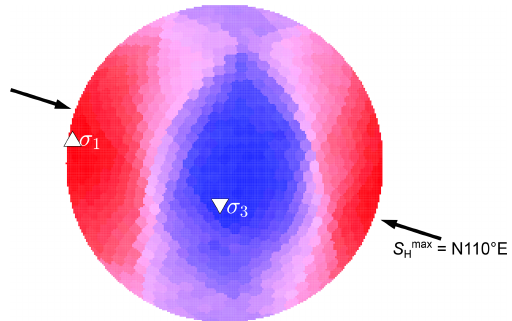
Figure 9. Stereonet of the estimated local stress field using the BRTM. White upward- and downward-pointing triangles represent maximum and minimum principal stress axes σ 1 and σ 3 , respec- tively. Black arrows represent maximum horizontal stress S max the